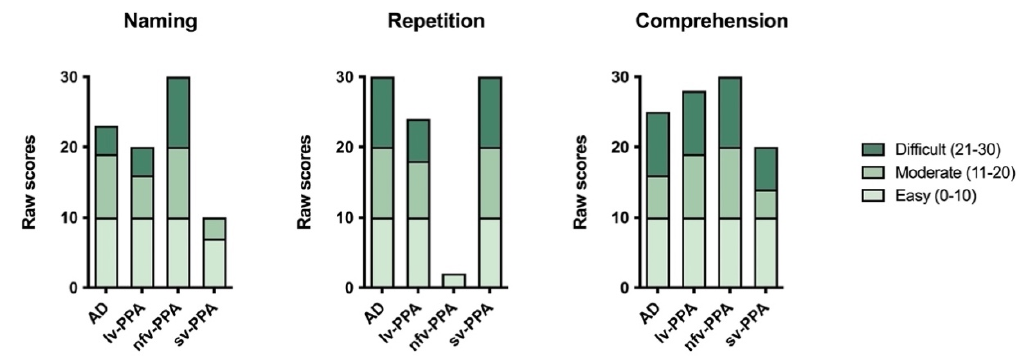
Figure 1. Raw scores on the Naming, Repetition, and Comprehension subtests of the Sydney Language Battery. Note, due to speech output difficulties, the nfv-PPA patient wrote their responses for the Naming subtest (Appendix A).